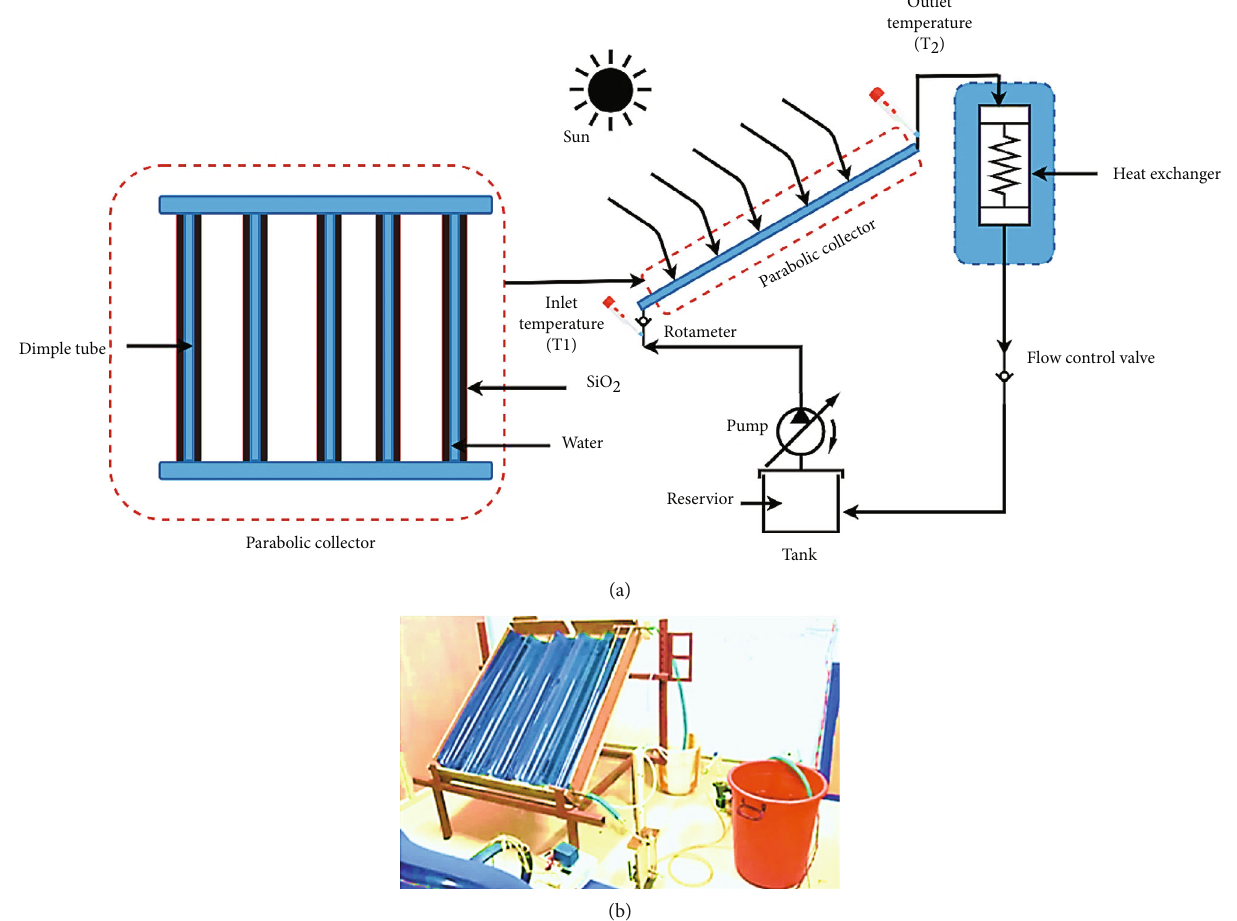
Figure 1: (a) Layout of the experimental setup. (b) Photograph of the experimental